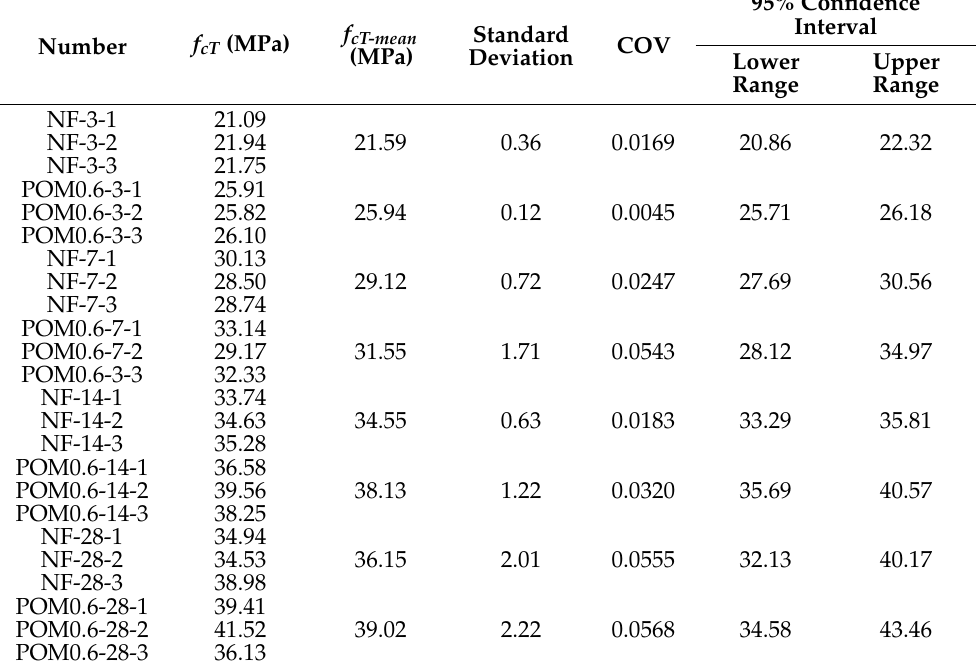
Figure 13. Failure performance of POM0.6 specimens with different ages after axial compressive test: ( a ) 3 d; ( b ) 7 d; ( c ) 14 d; and ( d ) 28 d. Table 6. Axial compressive strength of NF and POM0.6 specimens with different ages. f cT-mean Number f cT (MPa)